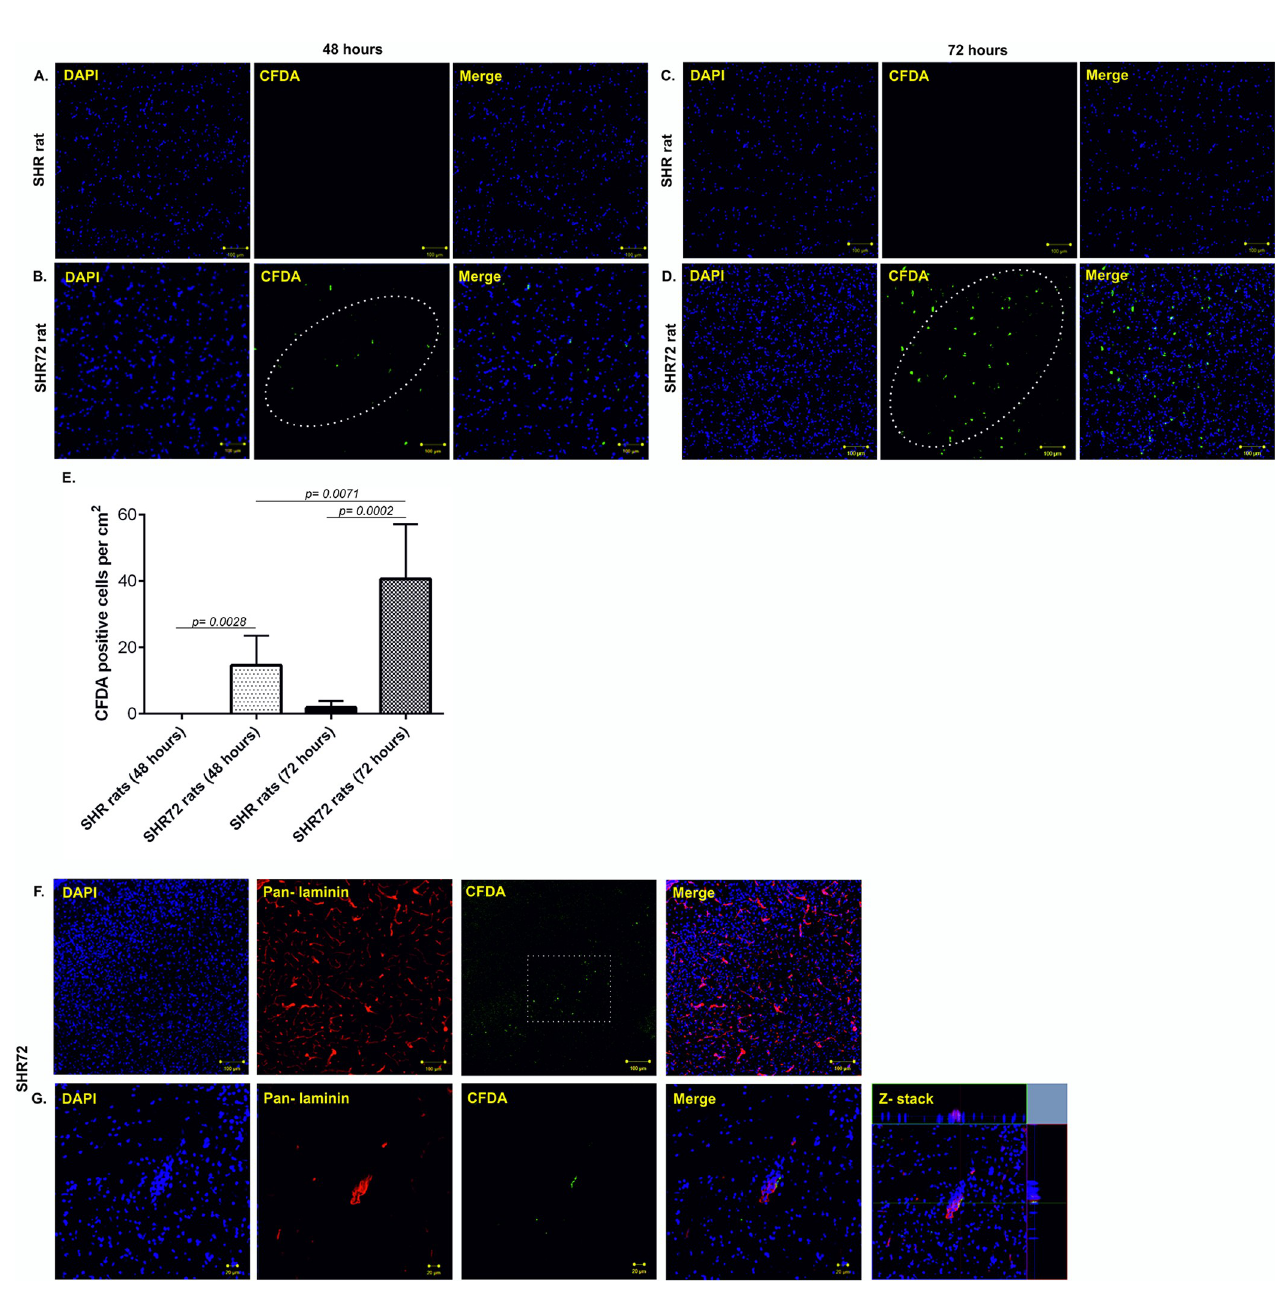
Fig 4. Active infiltration of CFDA—labeled PB-MoM cells into the area with neurofibrillary pathology. (A) CFDA- labeled PB-MoM cells in control SHR brain tissue (brainstem) after 48 hours. (B) CFDA- labeled PB-MoM cells in transgenic SHR-72 brain tissue (brainstem) after 48 hours. (C) CFDA- labeled PB-MoM cells in control SHR brain tissue after 72 hours. (D) CFDA- labeled PB-MoM cells in transgenic SHR-72 brain tissue after 72 hours. (E) Quantification of CFDA- labeled PB-MoM cells in the brainstem of control and transgenic rats after 48 and 72 hours. (F, G) Double immunostaining with pan- laminin showed the presence of intravascular CFDA- labeled cells. Scale bar: 100 μ m and 20 μ m, n = 4.